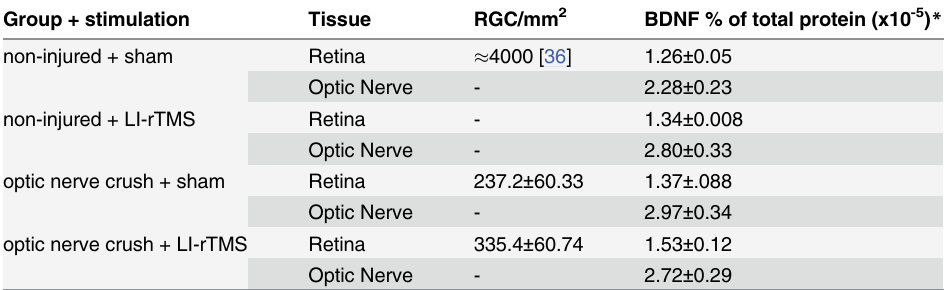
Table 1. RGC survival and BDNF concentrations following stimulation. Group + stimulation